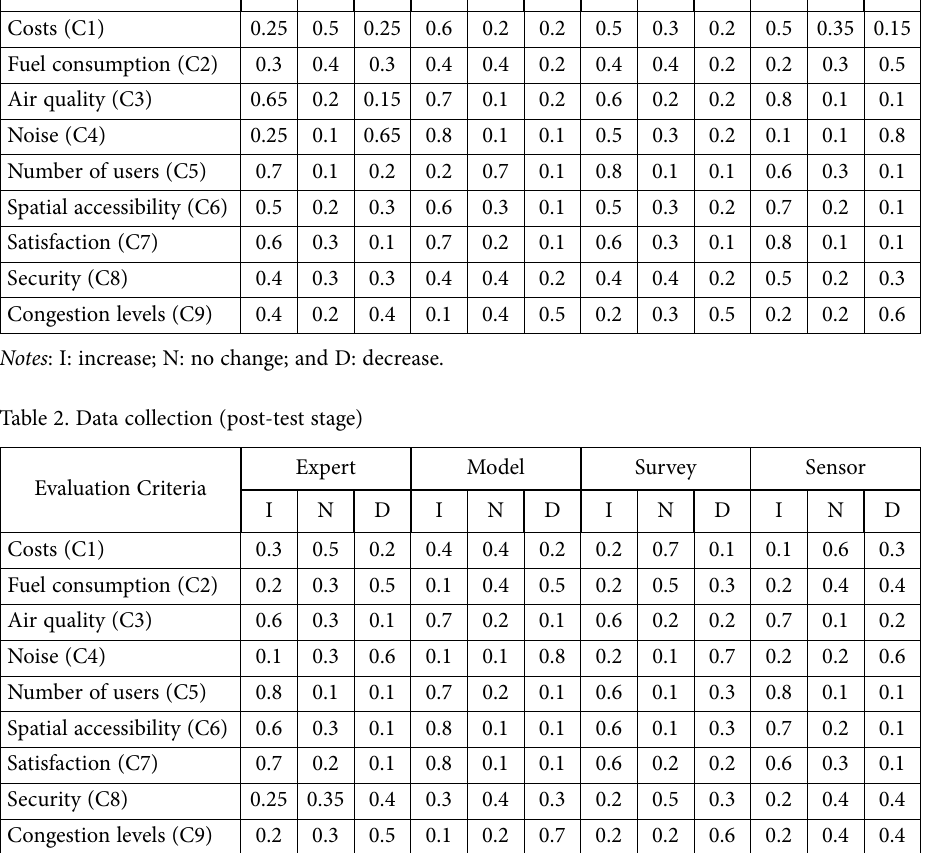
Table 1. Original data collection (pre-test stage) Evaluation Criteria